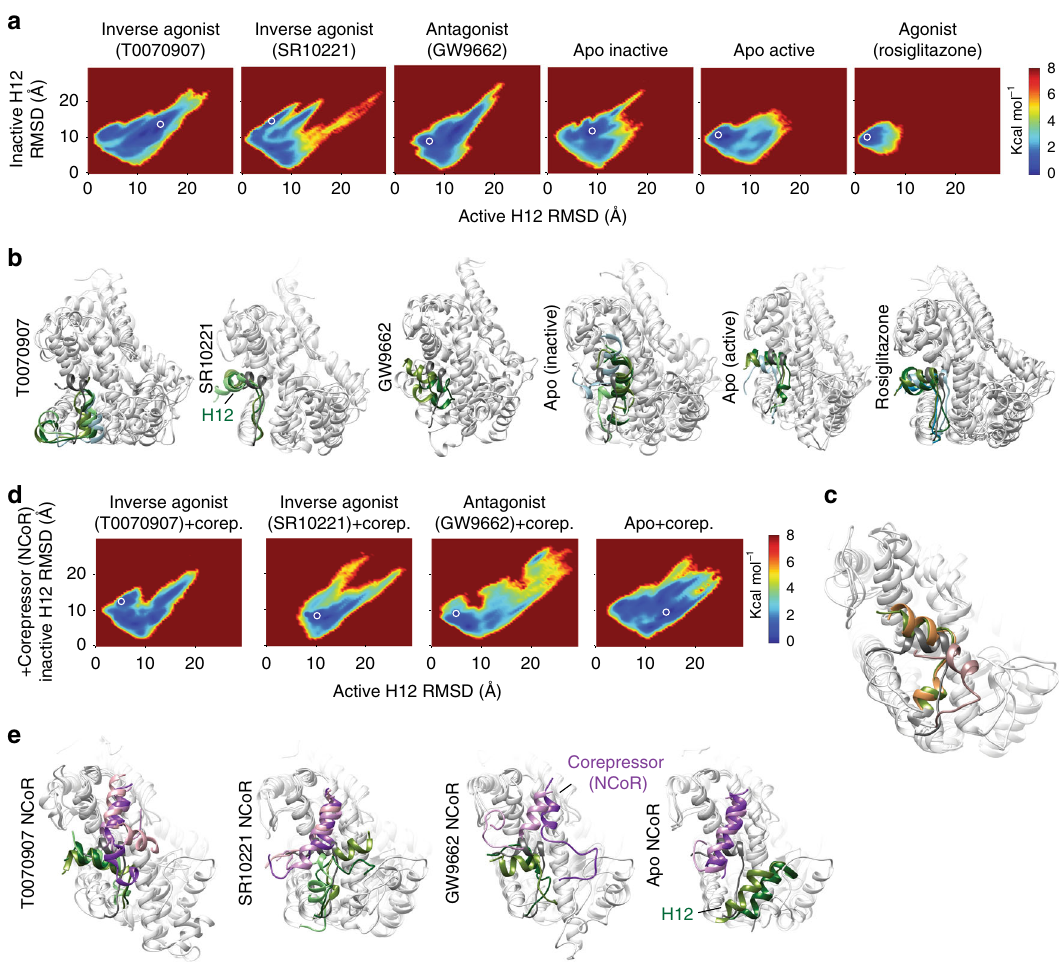
Fig. 2 Extensive aMD simulations indicate a diverse PPAR γ structural ensemble. Multiple independent aMD simulations were run for the indicated PPAR γ LBD complexes (see Supplementary Table 5). a , d The RMSD of helix 12 was calculated compared to active (chain A) and inactive (chain B) structures (PDB code: 1PRG). The energy of each trajectory snapshot was calculated and overlaid on the 2D RMSD to produce the displayed potential energy landscapes. b , e The aMD trajectory structures within a 0.2 × 0.2 Å RMSD square centered on the lowest energy wells (white circles in panels ( a ) and ( d )) were clustered using k-means clustering into 5 clusters using CPPTRAJ 81 . Arbitrary (i.e., CPPTRAJ chosen) representative structures are shown for the most prevalent clusters. The relative prevalence of the structure is indicated by the color of helix 12 ranging from dark green for the most prevalent to olive drab, light green, light blue, and then deep sky blue for the least prevalent. For reference, an active structure (rosiglitazone bound PPAR γ ; 2PRG chain A) is shown with helix 12 colored dim gray. c Representative structures from the third and second lowest energy wells in the inactive and active apo simulations, respectively, are shown in orange and dark green. Active and inactive crystal structures are shown in dim gray and light